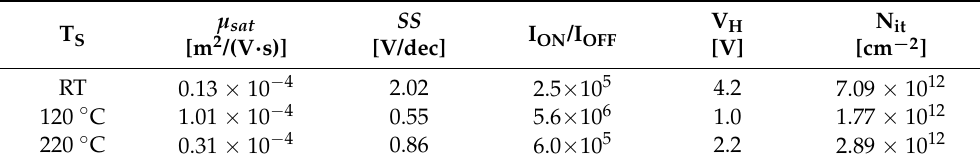
Table 1. Electrical parameters of solution-processed ZTO TFTs pre-annealed at different